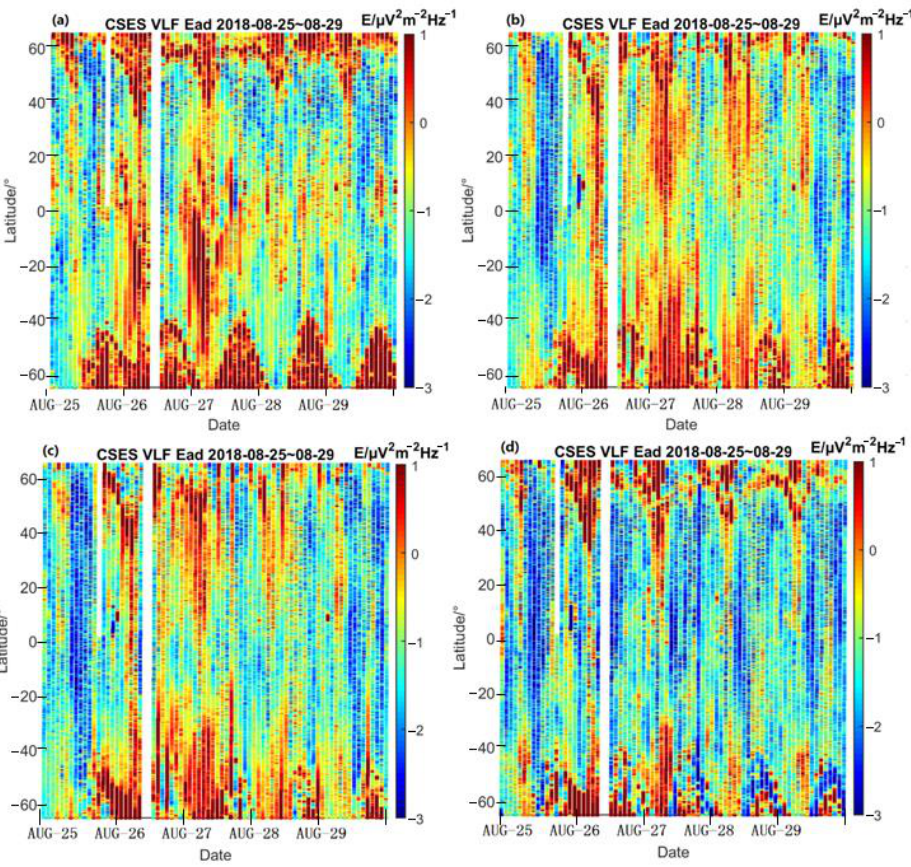
Figure 3. The electric field spectrum values at 6 frequency bands (( a ): 225 Hz; ( b ): 725 Hz; ( c ): 1125 Hz; ( d ): 7500 Hz) in local nighttime from 25 to 29 August in 2018.